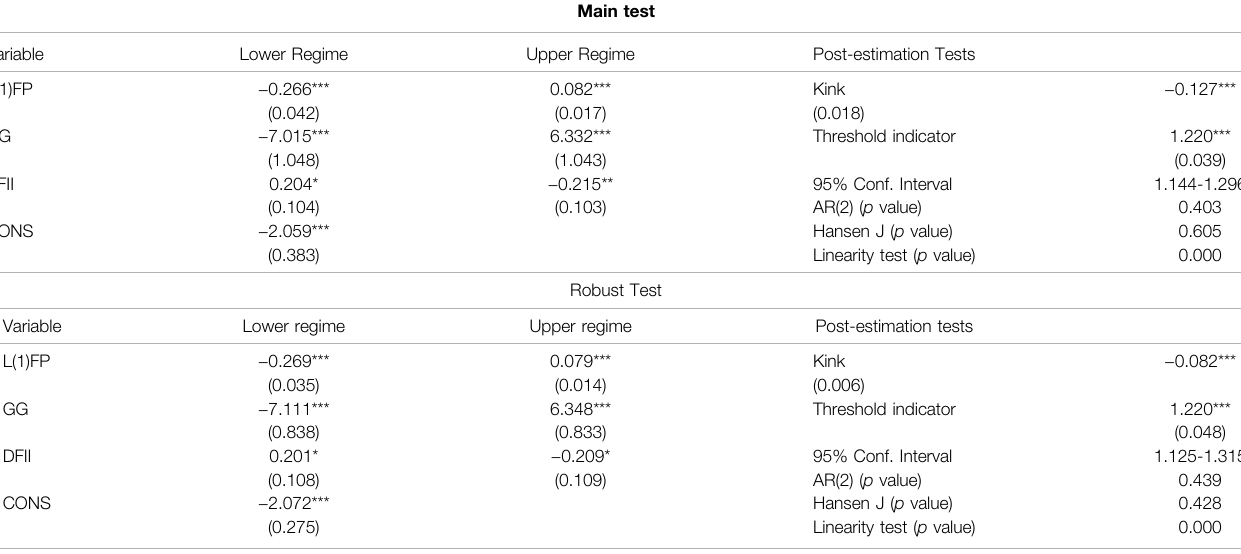
TABLE 8 | Results for the threshold effect of green growth (GG) on fl oating population